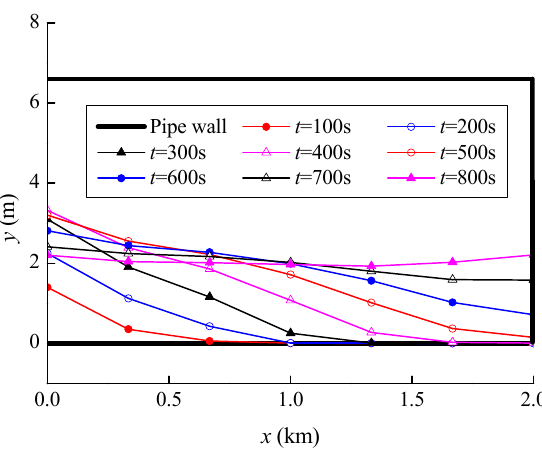
Figure 14. Water level along the pipeline in a water filling process (Stage 1).